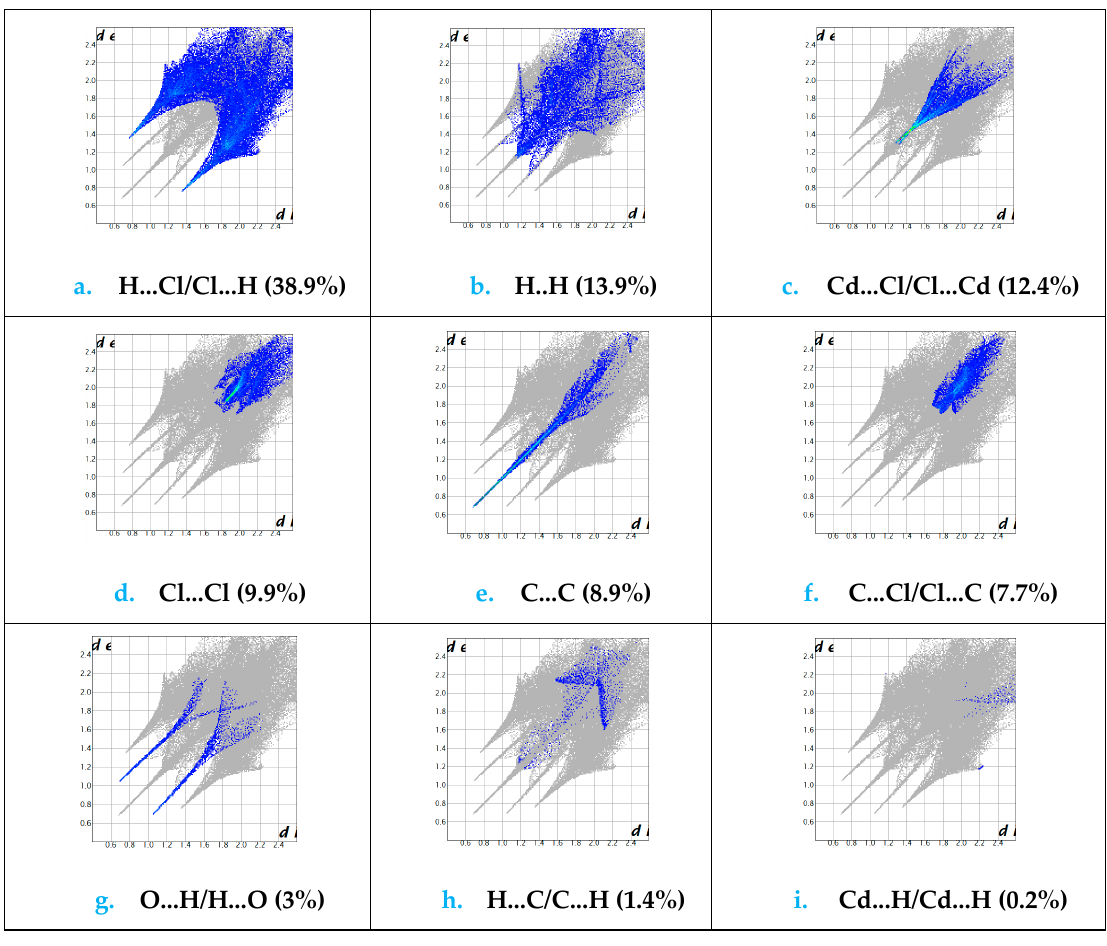
Figure 9. Fingerprint plots showing contribution from different contact. ( a ) H…Cl/Cl…H, ( b ) H…H, ( c ) Cd…Cl/Cl…Cd, ( d ) Cl…Cl, ( e ) C…C, ( f ) C…Cl/Cl…C, ( g ) O…H/H…O, ( h ) H…C/C…H, ( i ) Cd…H/H…Cd.